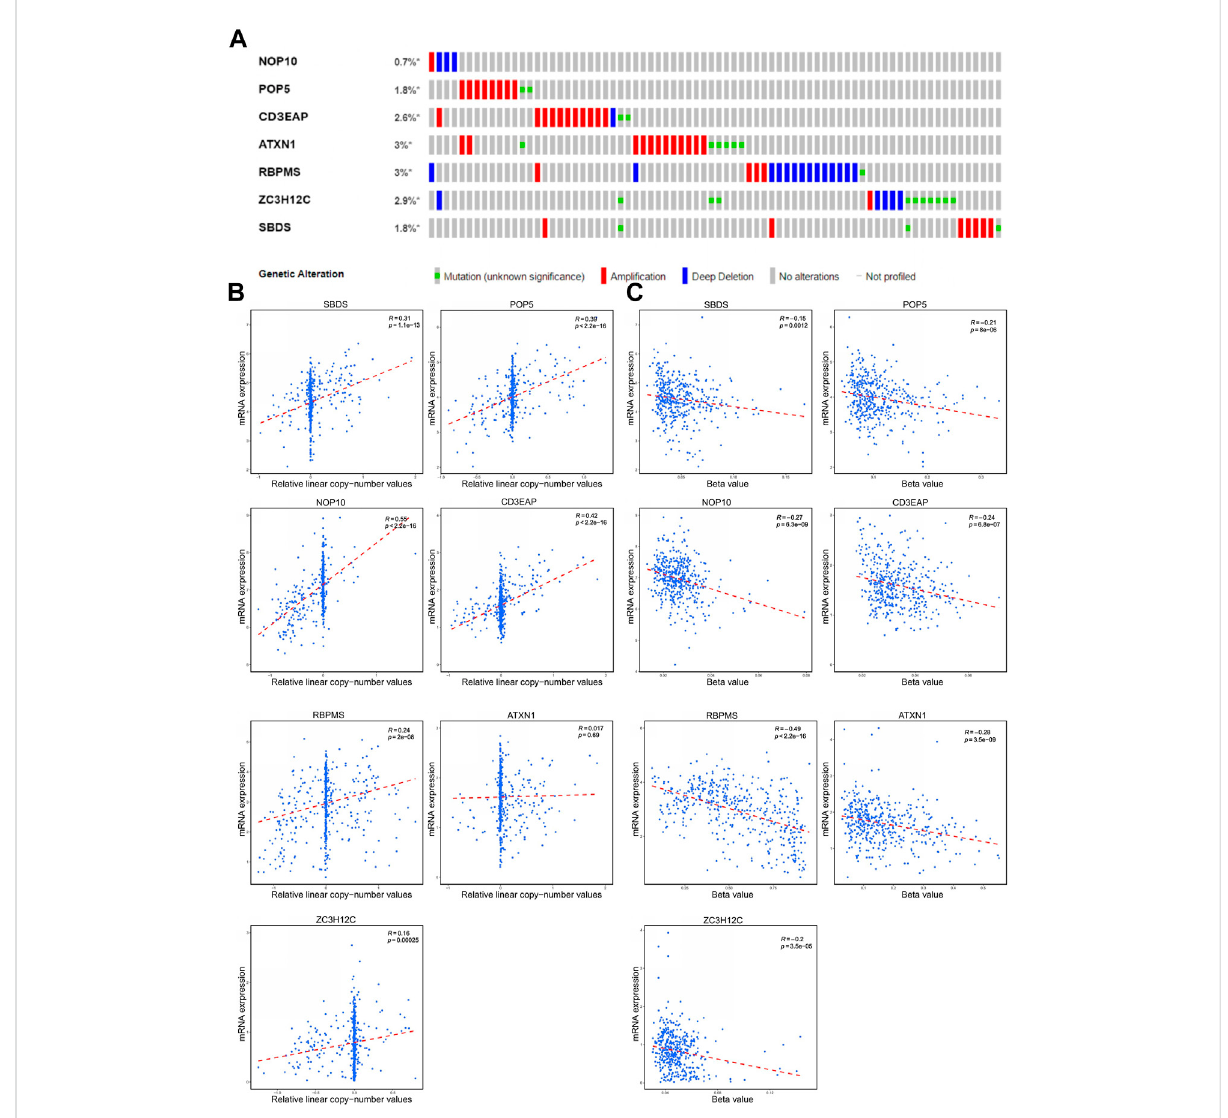
FIGURE 7 The genetic alterations and methylation of the seven hub RBPs (A) The genetic alterations of the seven genes. (B) The correlation between mRNA expression and copy number values of the seven genes. (C) The correlation between mRNA expression and DNA methylation of the seven